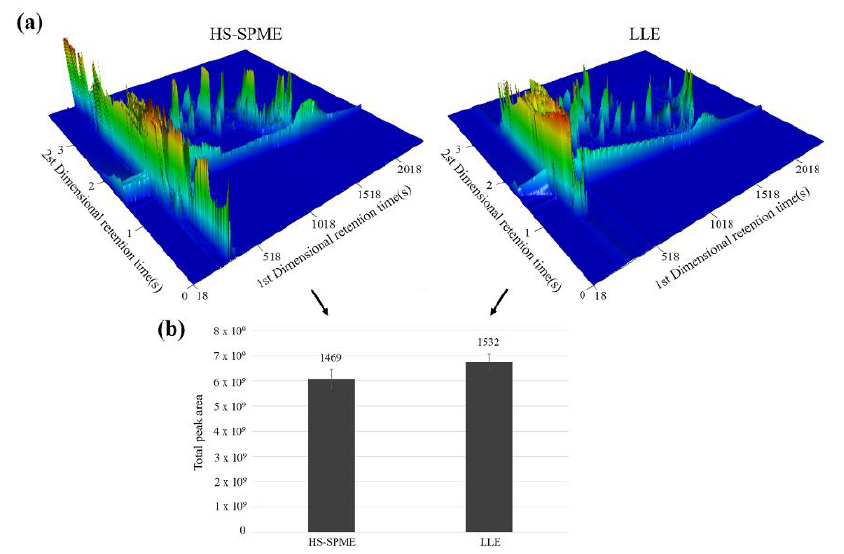
Figure 1. Three-dimensional visualization of raw HS-SPMEDVB/CAR-PDMS /GC × GC/TOF-MS data. ( a ) chromatography 3D plot of Fen liquor extracted by the HS-SPME and ( b ) the LLE. More peaks were detected by the HS-SPMEDVB/CAR-PDMS compared to the LLE, especially, in 17 min in 1st dimensional time according to the 3D plot. Some low abundance peaks invisible using the HS-SPMEDVB/CAR-PDMS could be detected by performing the LLE around 25 min in 1st dimensional time.